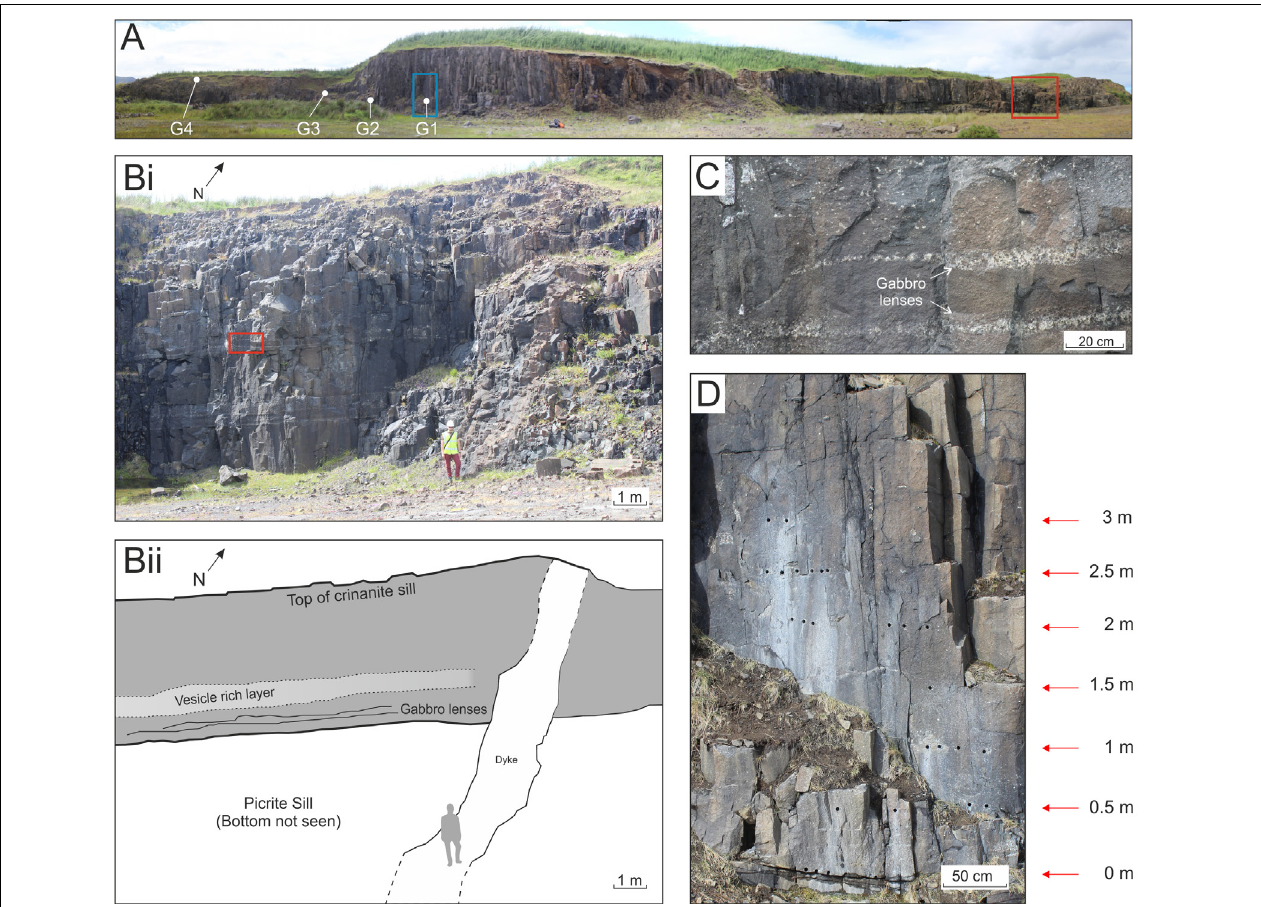
FIGURE 2 | Field photographs of crinanite and picrite sills that crop out in a quarry at Inver Tote. (A) Overview panoramic photograph showing magnetic sampling sites (G1-4), and the blue and red boxes are the locations of photos (B,D) . (Bi) Photograph showing a crinanite sill, a picrite sill and a basaltic dyke. The red box is the location of photograph (C) , and (Bii) is an interpretive drawing of (Bi) which shows the location of the units present. (C) Photograph of the lower portion of the crinanite sill showing the gabbro lenses. (D) Photograph of drill holes across the lowest 3 m of sampling heights in the crinanite sill (location